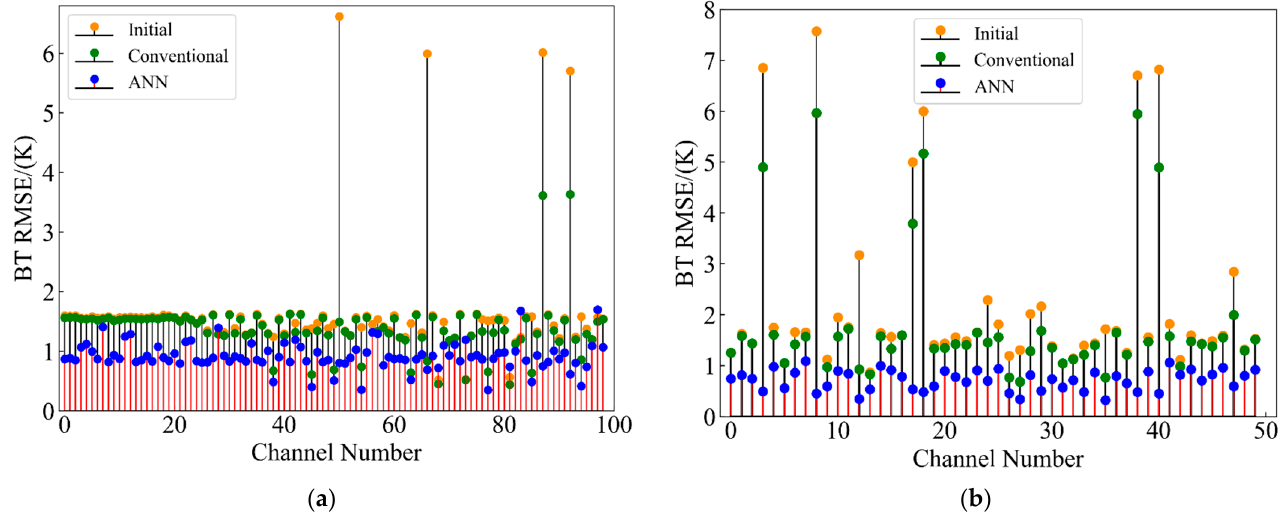
Figure 9. Channel observation error correction before and after comparison. ( a ) Temperature; ( b ) humidity.